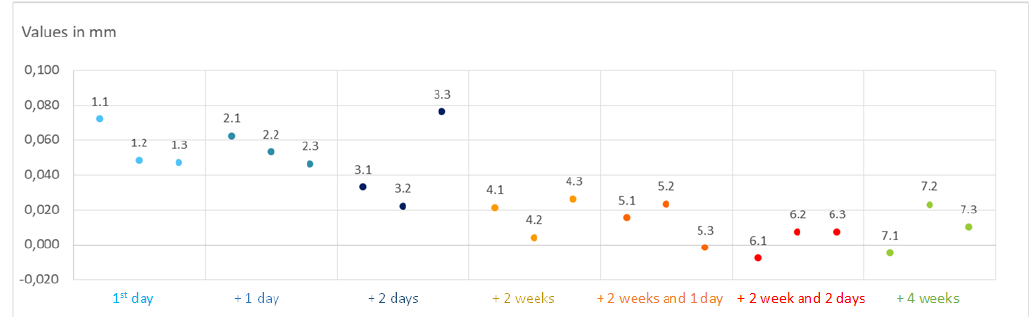
Appl. Sci. 2020 , 10 , x FOR PEER REVIEW